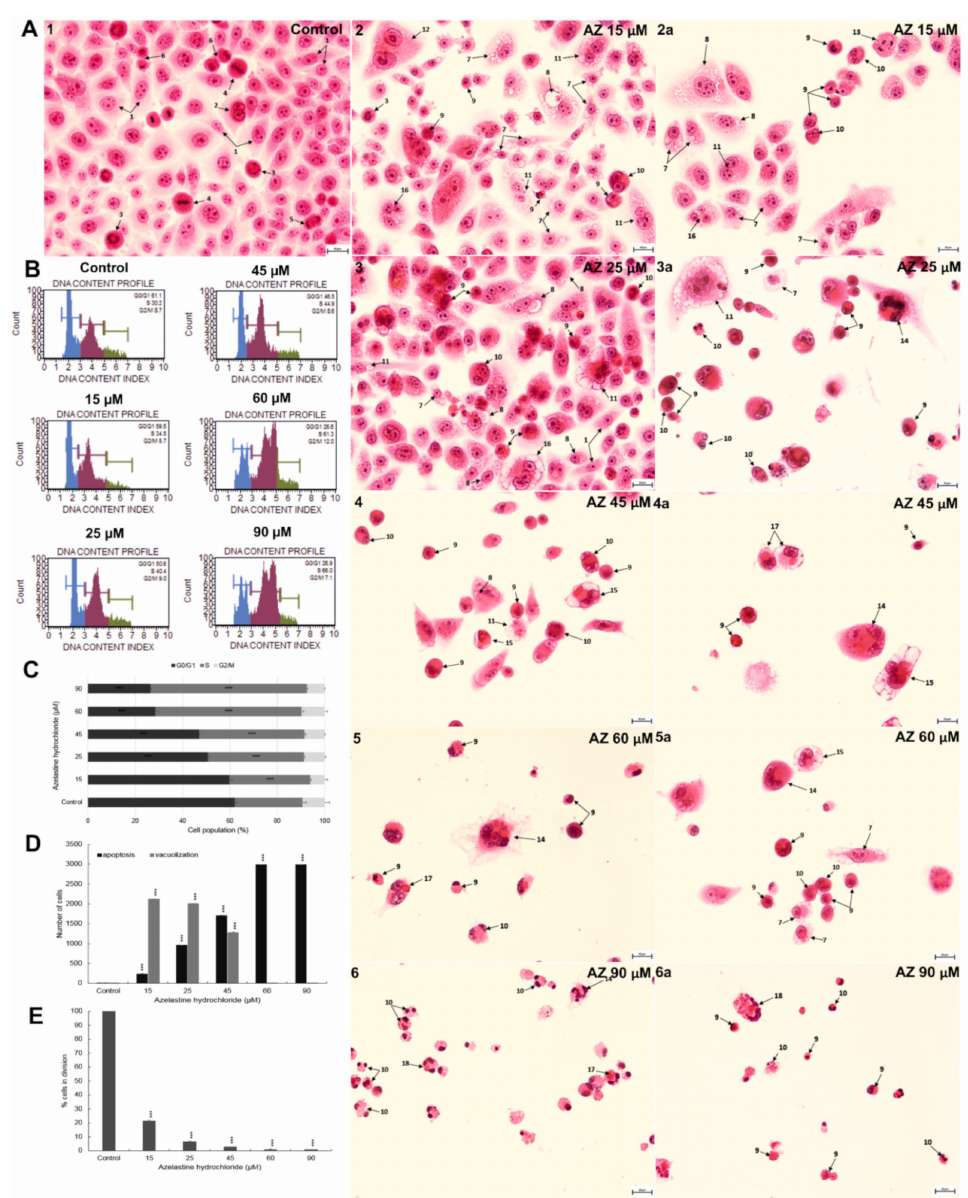
Figure 4. Morphological changes indicating the induction of vacuolating and apoptotic changes and a decrease in the dividing capacity of Hela cells as a consequence of 48 h treatment with azelastine hydrochloride. ( A1 ) Control cells with normal morphology, including interphase cells and cells